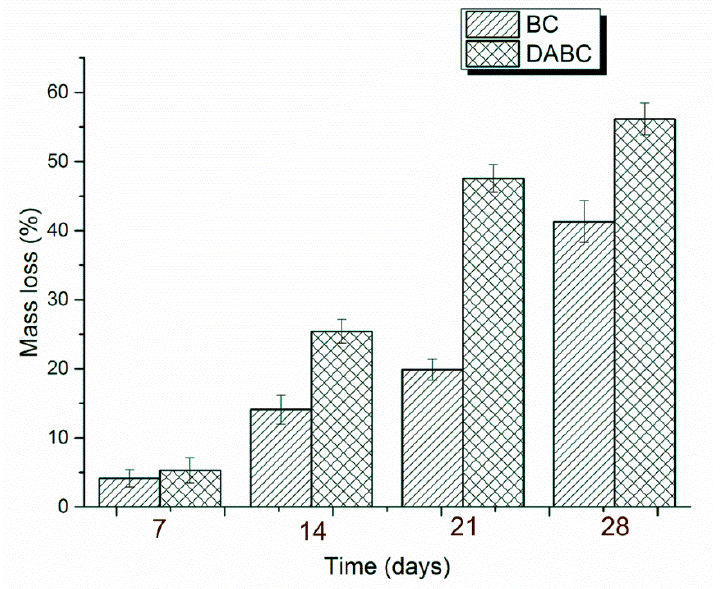
Figure 8. Percentage of mass loss for BC and DABC during in vitro degradation (n = 3; error bars =